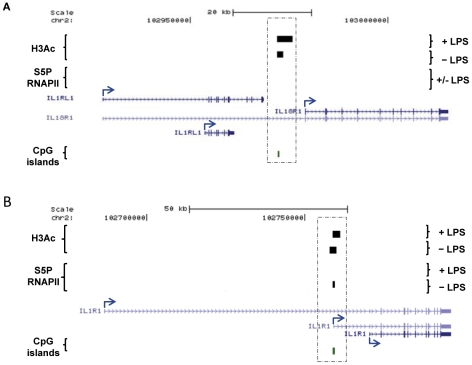
Group 1: Up-regulated cytokines.(A) IL18R1 lacks a proximal promoter H3Ac peak but LPS opens it to within 3 kb of TSS. Alternative annotated promoters/TSSs of IL18R1 did not contain signals for H3Ac or RNAPII within a 2 kb distance upstream of the known TSS. However, an H3Ac peak is present approximately 5 kb upstream of the TSS (highlighted by the square) and in LPS-stimulated macrophages it is increased in size and comes to within 3 kb of the TSS. (B) The IL1R1 intermediate isoform promoter harbours a common H3Ac peak and a unique S5P RNAPII peak in its promoter suggesting specific regulation of the gene at this annotated TSS in macrophages. Genes identified by RefSeq using the UCSC browser are shown with blue arrows indicating TSSs locations and directions.